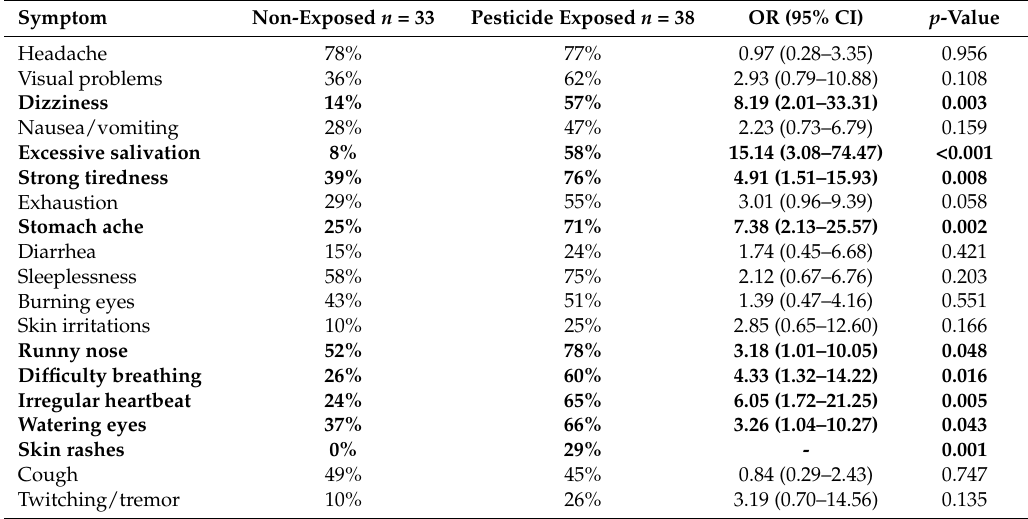
Table 3. Symptoms reported by non-exposed and pesticide exposed workers. Odds ratios (OR), 95% confidence intervals and p -values for pesticide use corrected for age, body mass index and education (sig. results in bold